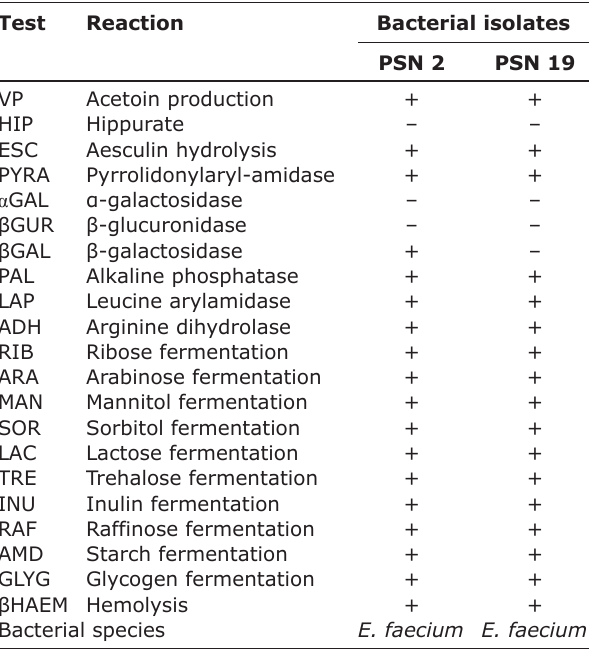
Table-1: The results biochemical identification by the Kit API 20 strep of PSN 2 and PSN 9. Test